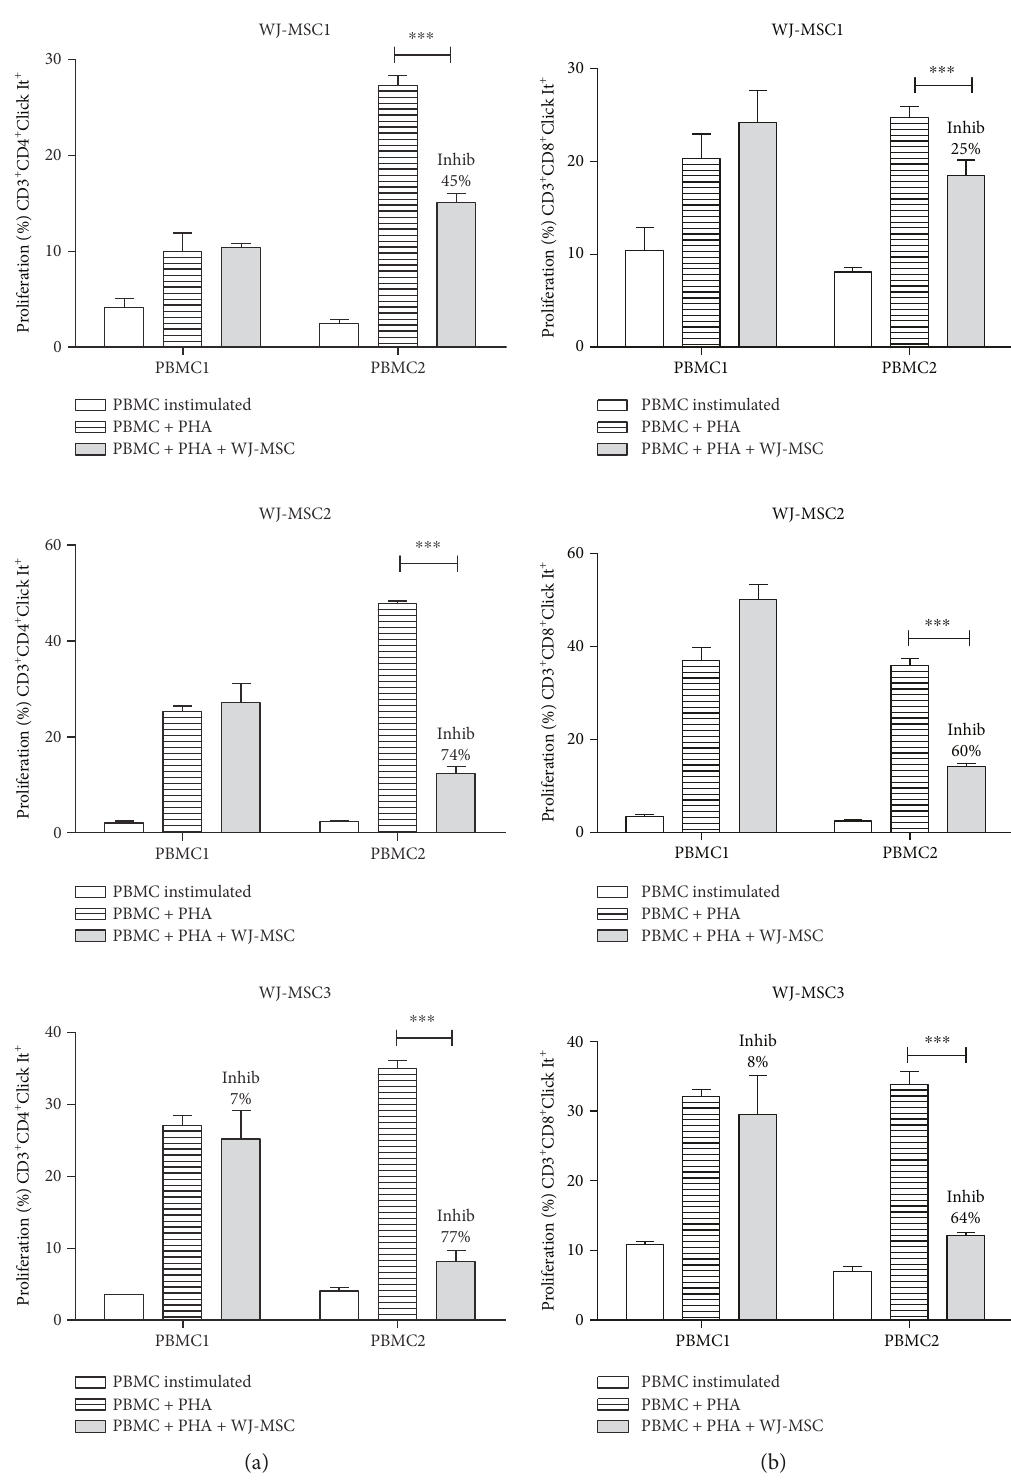
Figure 3: WJ-MSC inhibit CD3 + CD4 + and CD3 + CD8 + T cell proliferation. WJ-MSC were seeded, after 24 hours. PBMC was added and stimulated with PHA for 3 days in the presence of WJ-MSC; the ratio used was 1 :10 (WJ-MSC : PBMC). The WJ-MSC passages used in experiments were either P5 or P6. T cells were collected, stained with anti-CD3, anti-CD4, and anti-CD8 antibodies, and proliferation was measured by fl ow cytometry using the Click It Kit. (a) % proliferation of CD3 + CD4 + Click It + T cell and (b) % proliferation of CD3 + CD8 + Click It + T cell. The percentage of inhibition (Inhib) was calculated using the percentage of proliferation of PBMC + PHA+WJ-MSC compared to the control PBMC + PHA. Experiments were performed in triplicate. Results are represented by mean ± SD. Statistically signi fi cant di ff erences are shown as ∗∗∗ p < 0 0001 ( n = 3